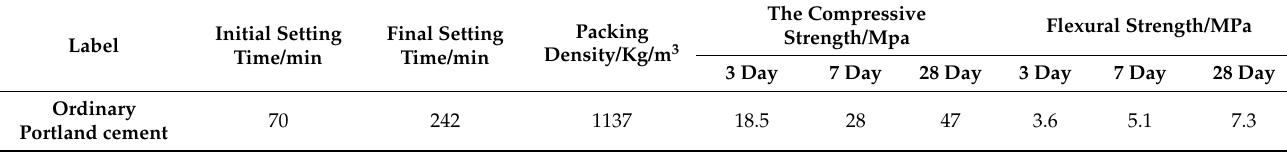
Table 1. Cement physical performance indicators.